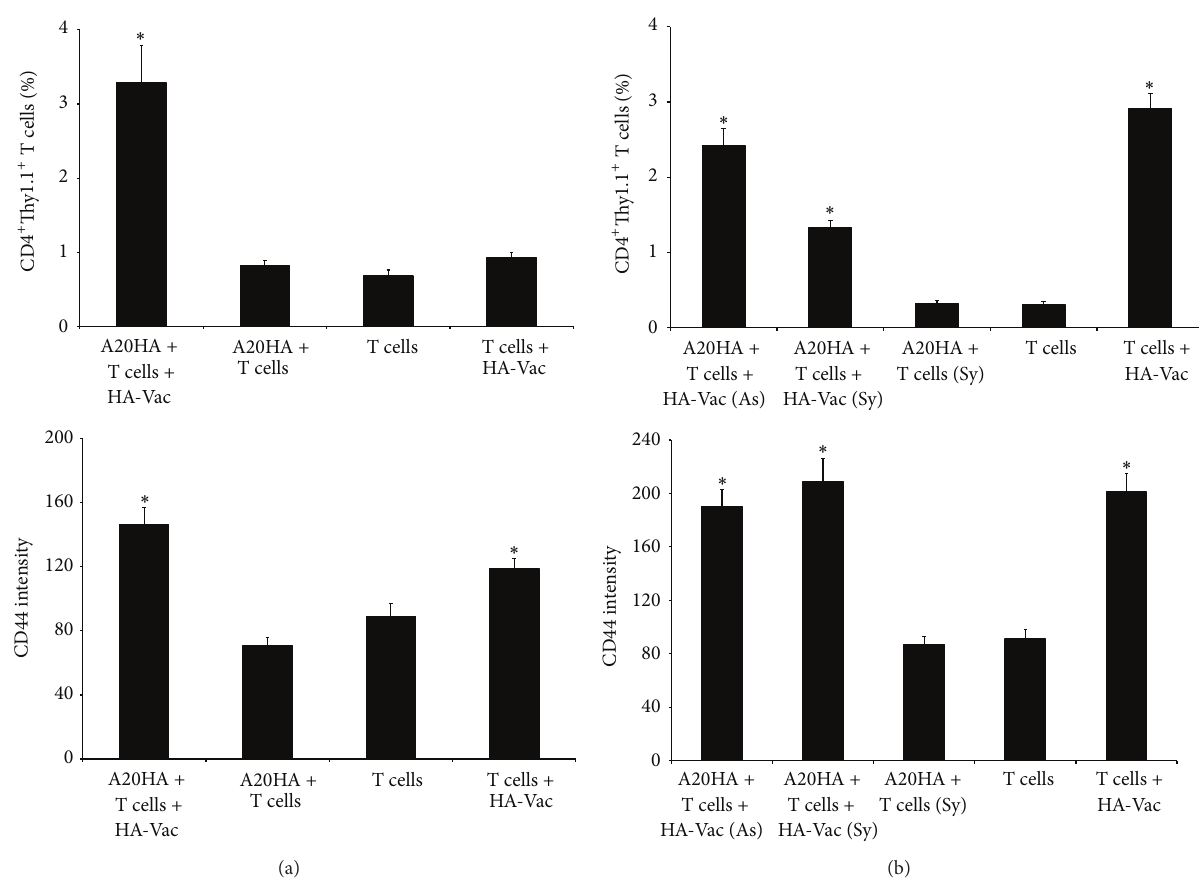
Figure 6: Virus HA vaccination at late stages of A20HA brain tumor progression stimulates activation of residual HA-specific CD4 + T cells in vivo .((a),(b))PercentofCD4 + Thy-1.1 + Tcells(upper)andintensityofCD44expression(lower)bycellsisolatedfrom(a)cervicallymphnodes and (b) spleens from separated asymptomatic (As) and symptomatic (Sy) mice on day 18 after the adoptive transfer. HA-specific CD4 + Thy1.1 + T cells were injected i.v. to A20HA brain tumor-bearing mice on day 5 after i.c. tumor inoculation. Virus HA-Vac was delivered i.p. on day 15 after the adoptive transfer. Individual cervical lymph nodes and spleens of asymptomatic and symptomatic mice (three mice per group) were analyzed by FACS for CD4 + CD44 + Thy1.1 + T cells. A20HA + T cells + HA-Vac, mice that received A20HA tumor cells, HA-specific CD4 + Thy1.1 + T cells and virus HA-Vac; A20HA + T cells, mice that received A20HA tumor cells and HA-specific CD4 + Thy1.1 + T cells; T cells + HA-Vac, mice that received HA-specific CD4 + Thy1.1 + T cells and virus HA-Vac; T cells, mice that received only HA-specific CD4 + Thy1.1 + T cells. Data are represented as the mean ± SD, 𝑛 = 3 . ∗ 𝑃 < 0.05